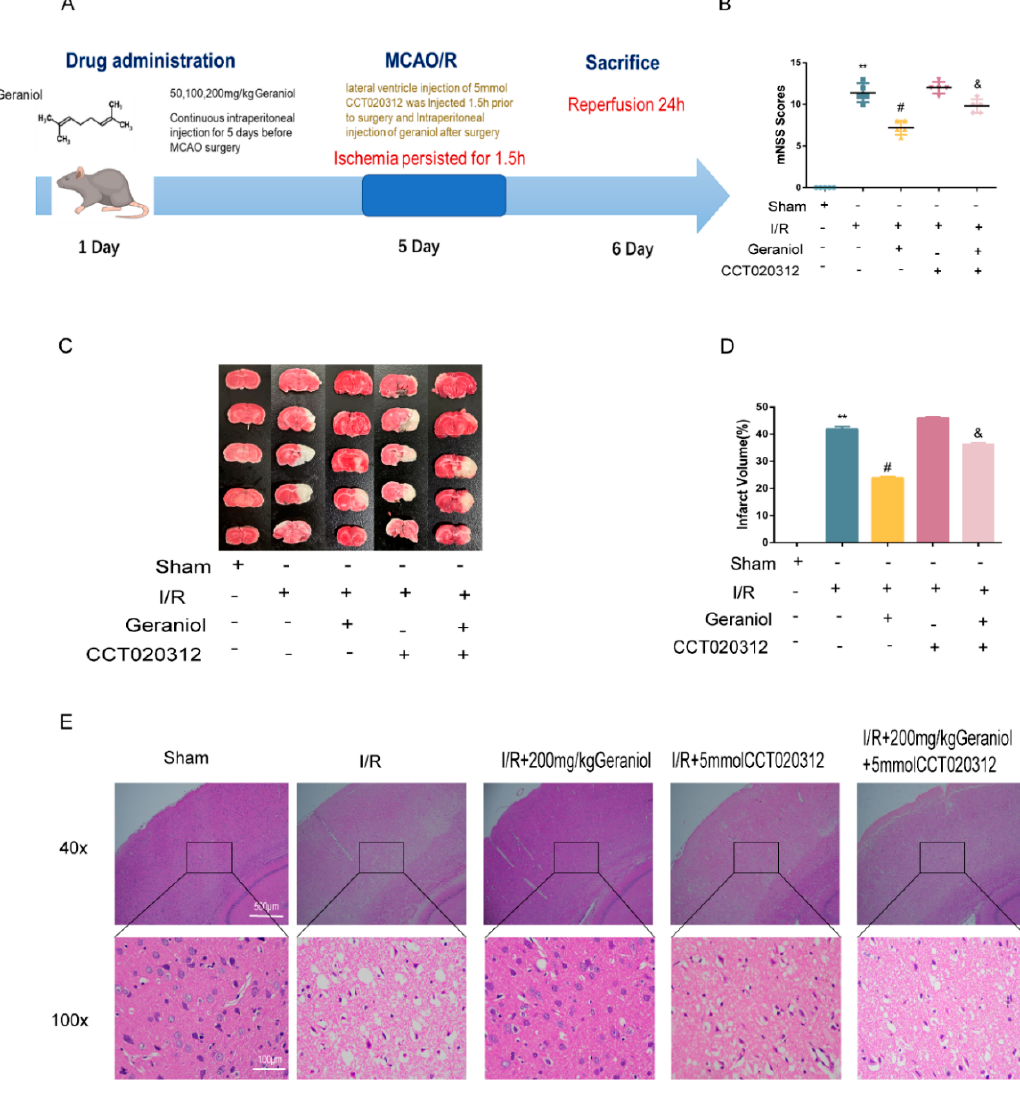
Figure 5. Geraniol had a protective effect on cerebral cortex ischemia–reperfusion (I/R) through the PERK-ATF4-CHOP signaling pathway in vivo. ( A ) Experimental protocol for rats. ( B ) Modified neurological severity score (mNSS) of ischemic rats and score analysis ( n = 6). ( C , D ) Representative images of 2, 3, 5-triphenyl tetrazolium chloride staining and statistical analysis of the brain infarct volume (n = 3). ( E ) Representative hematoxylin-and-eosin-stained cerebral slices imaged via microscopy. ** p < 0.01 I/R group vs. sham group, # p < 0.01 I/R + 200 mg/kg geraniol group vs. I/R group, & p < 0.01 I/R + 200 mg/kg geraniol+5 mmol CCT020312 group vs. I/R + 200 mg/kg geraniol group.